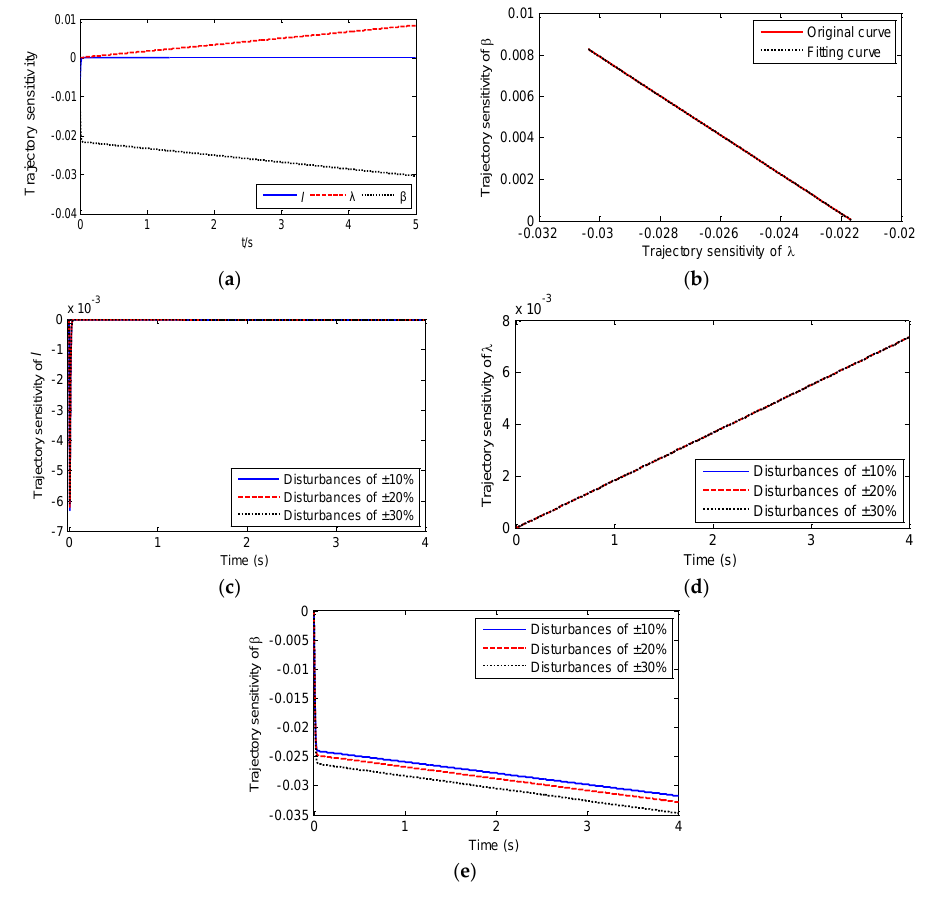
Figure 13. Sensitivity analysis of parameter change without temperature feedback. ( a ) Trajectory sensitivity with parameter disturbances of ±10%; ( b ) fitting relationship between the trajectory sensitivity of β and λ ; ( c ) trajectory sensitivity with different disturbance depths for l ; ( d ) trajectory sensitivity with different disturbance depths for λ ; and ( e ) trajectory sensitivity with different disturbance depths for β .